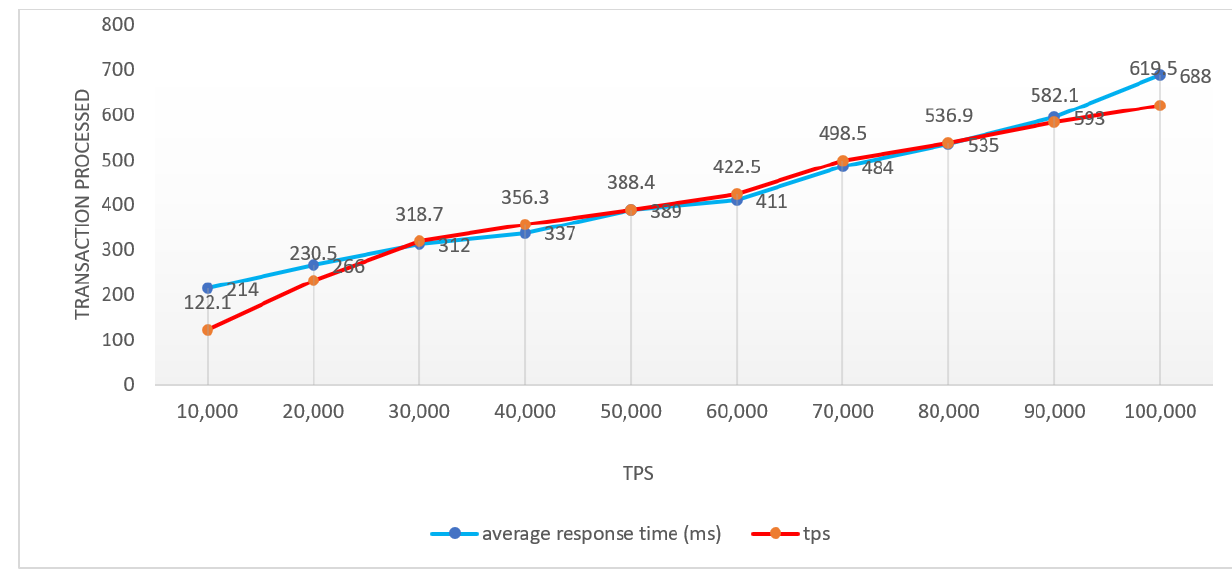
Figure 8. Graphical representation of the simulation order processing process (TPS).